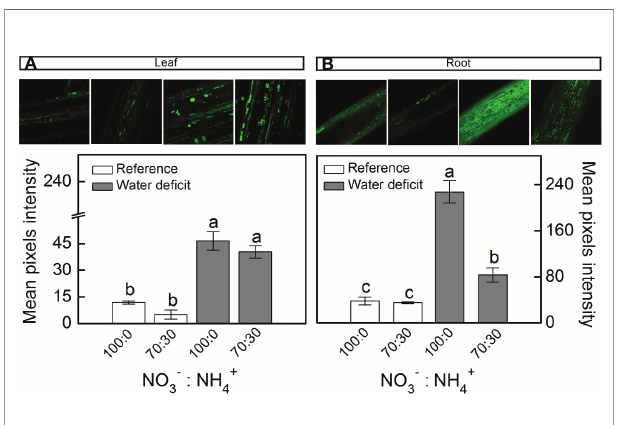
FIGURE 3 | Confocal microscopy images showing intracellular NO synthesis in leaves (A) and roots (B) of sugarcane plants maintained well-hydrated (reference, white bars) or subjected to water de fi cit (gray bars) and supplied with varying NO 3 − :NH 4 + ratios: 100:0 and 70:30. Mean pixel intensities are also shown. Bars represent the mean value of four biological replicates ± se. Different letters indicate statistical difference among treatments (BF 10 > 3 for leaf; BF 10 > 20 for root).